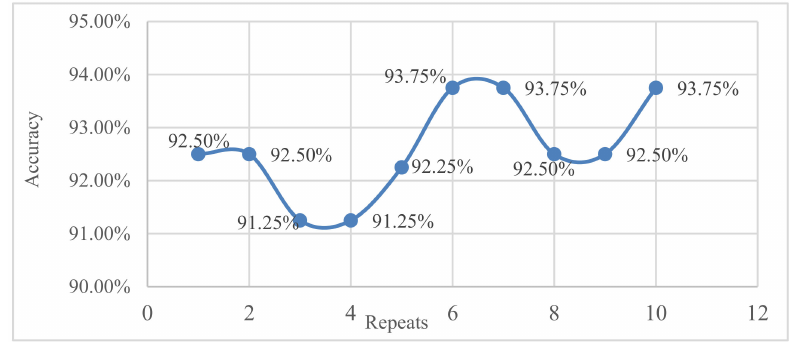
Figure 11. The 10-time evaluation accuracy.